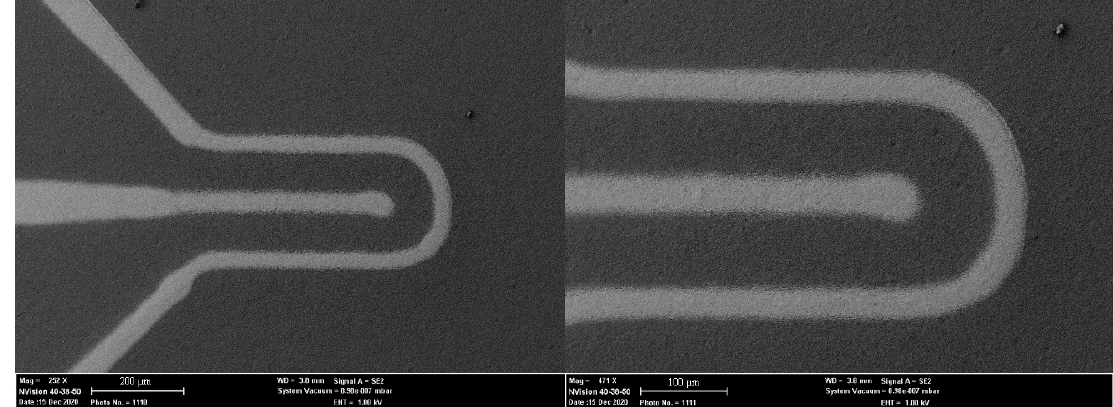
Appl. Sci. 2021 , 11 , x FOR PEER REVIEW Figure 13. SEM images of the microheater presented in Figure 12. Figure 13. SEM images of the microheater presented in Figure 12.